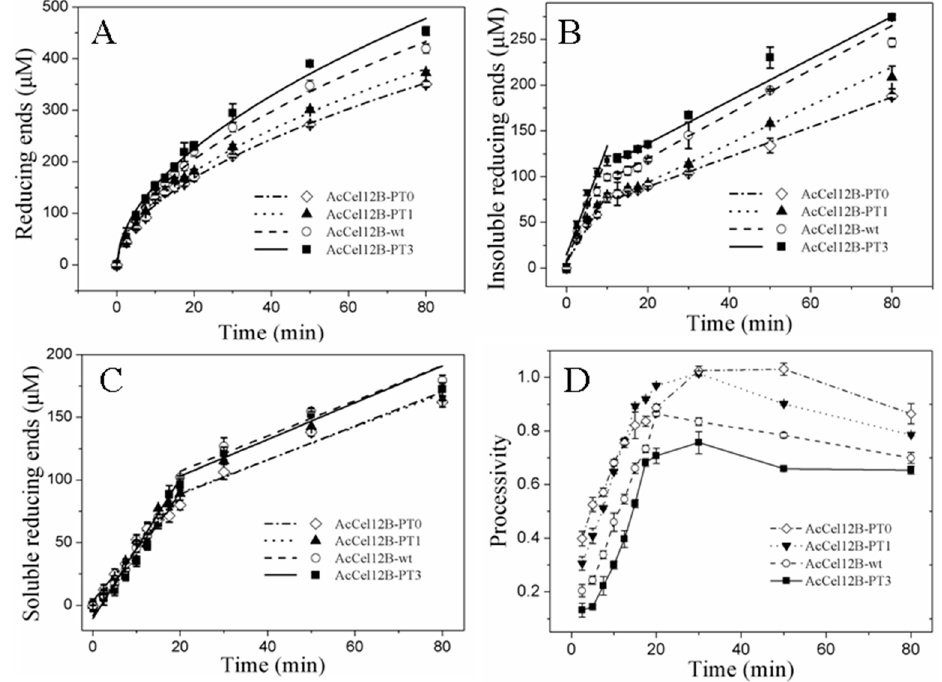
Figure 3. Time course of hydrolysis of RAC by wild ‐ type AcCel12B and its mutants. ( A ) AcCel12B and its mutants were incubated with RAC and the reducing ends generated was calculated and fitted to Equation (1). ( B , C ) Time course of insoluble reducing ends ( B ) and soluble reducing ends ( C ) of the hydrolysis of RAC by AcCel12B and its mutants. ( D ) The processivity of AcCel12B and its mutants at indicated time points. RAC incubated with thermal inactivated recombinant protein was used as a blank. All data were averaged from triplicate measurements. Table 2. Fitting curve parameters of the time course of RAC hydrolysis.